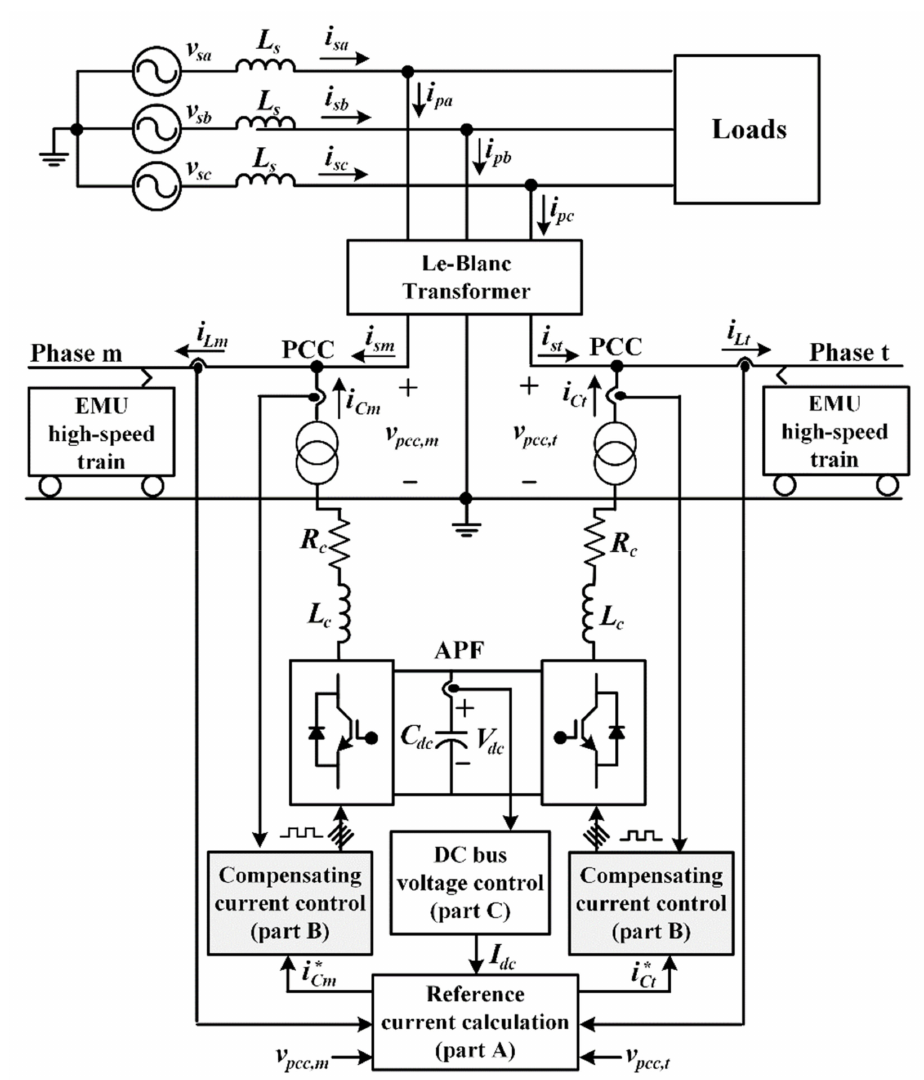
Figure 1. The structure of electric railway system and the control strategy of the harmonic mitiga- tion system using an active power filter (APF). EMU: electric multiple unit (EMU); PCC: point of common